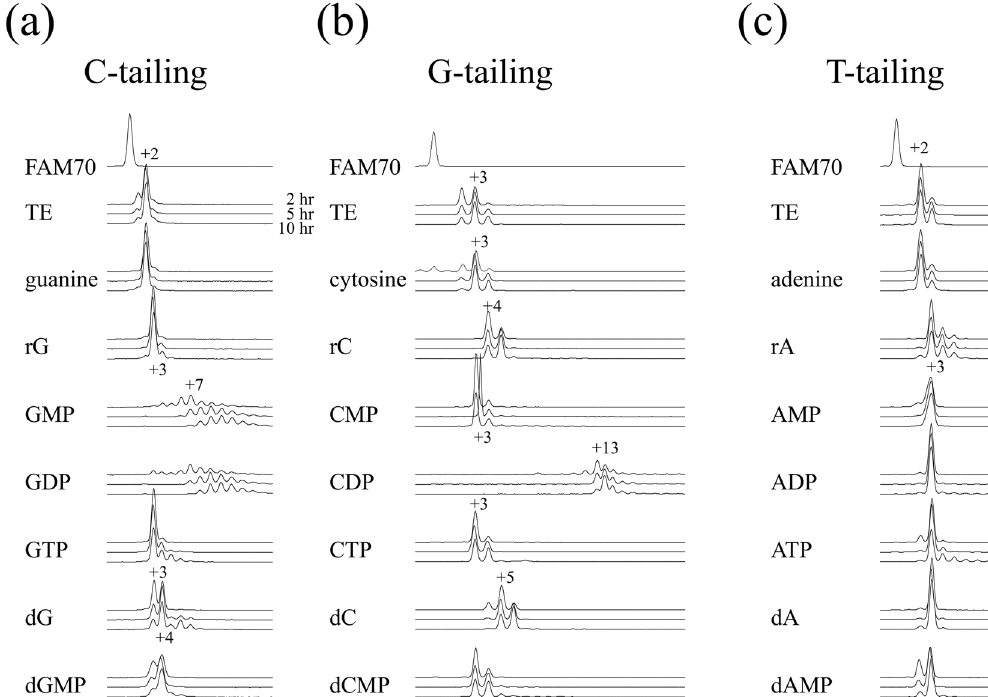
Figure 5. Reaction products after prolonged incubation with MMLV-RT. FAM70 DNA was incubated with MMLV-RT in the presence of each of the enhancing compound for 2 h, 5 h, and 10 h. Concentrations of the compounds are equal to those in Fig. 3. Some peaks are labeled with the size relative to the unreacted FAM70. ( a ) C-tailing, ( b ) G-tailing, ( c ) T-tailing reactions.